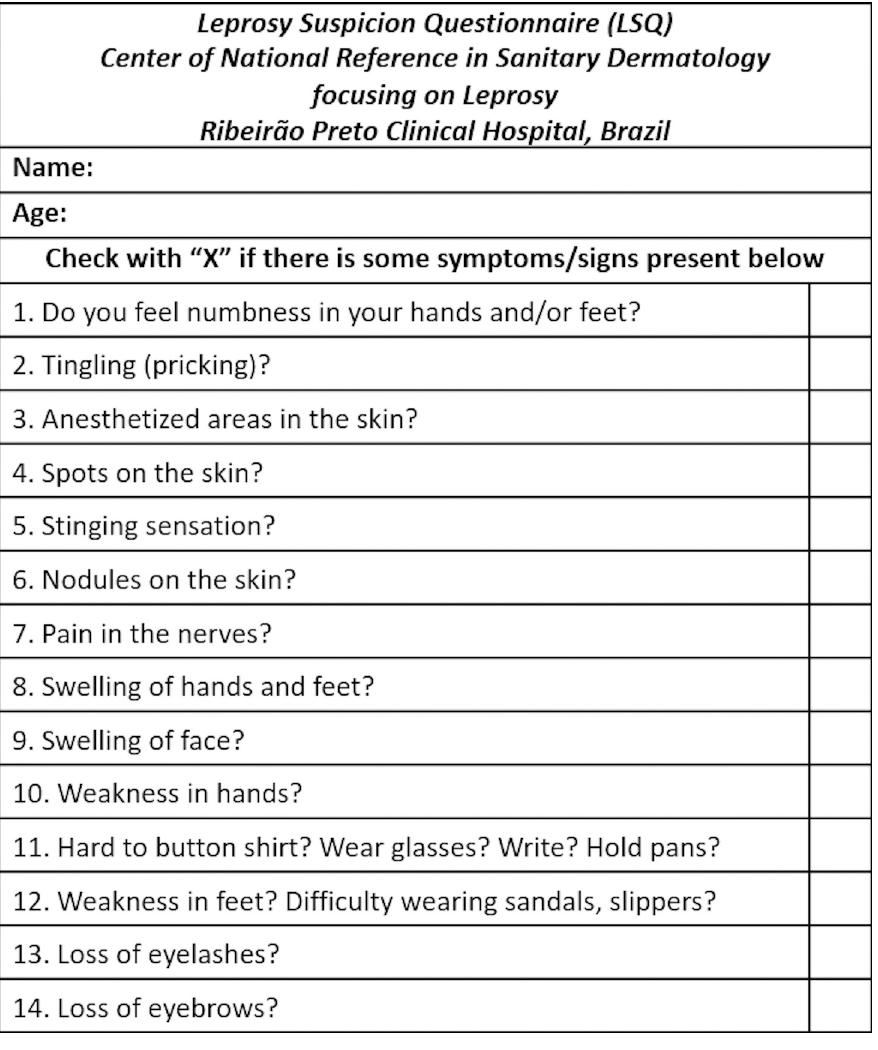
Fig 1. Leprosy Suspicion Questionnaire